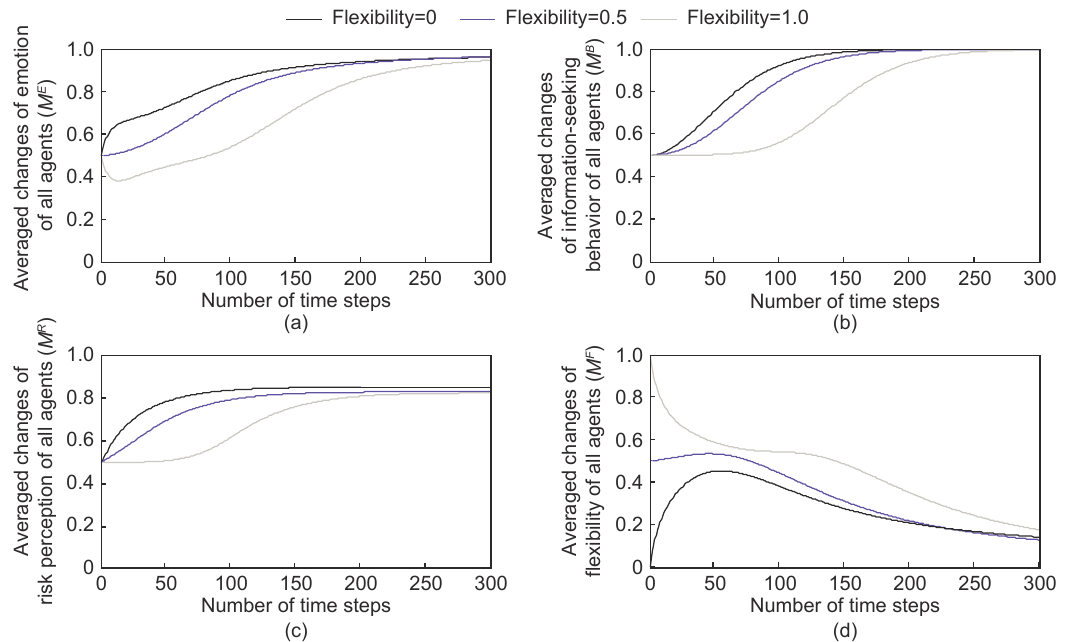
Fig. 3 Effects of flexibility on collective behavior and mental characteristics. The dynamic change of emotion, information- seeking behavior, risk perception, and flexibility of all agents are shown. Results are provided for three different initial values of flexibility (0, 0.5, and 1). The time duration of the dynamic evolution is 300 time